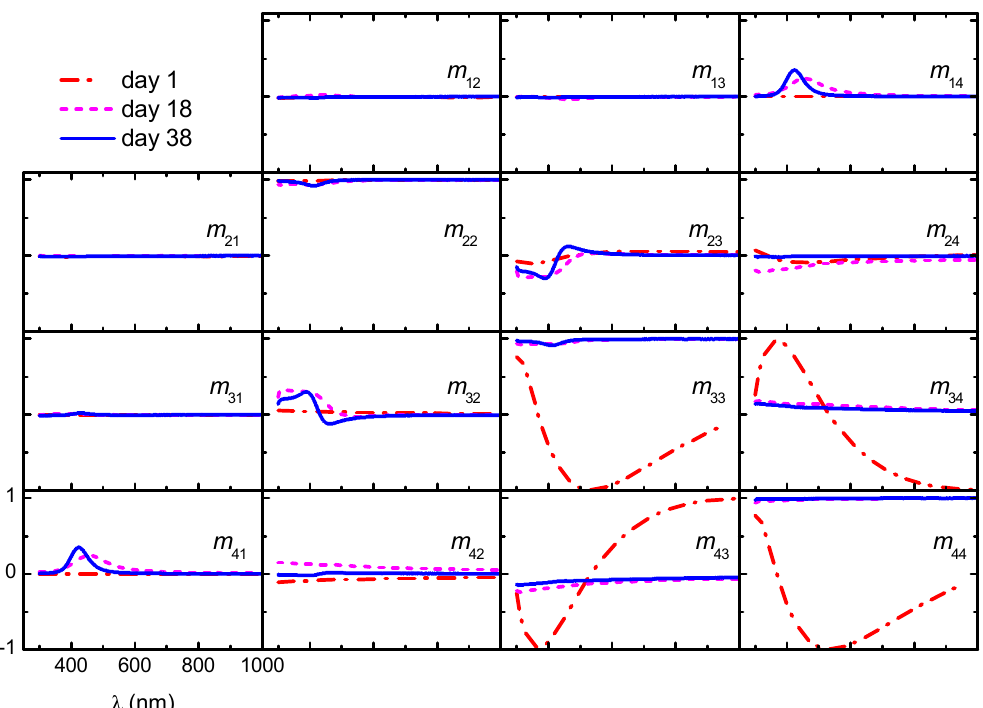
Figure 6. Evolution of Mueller matrices in transmission mode of films deposited from CNC suspensions with different times of storage. Scales are shown in the lower-left panel.